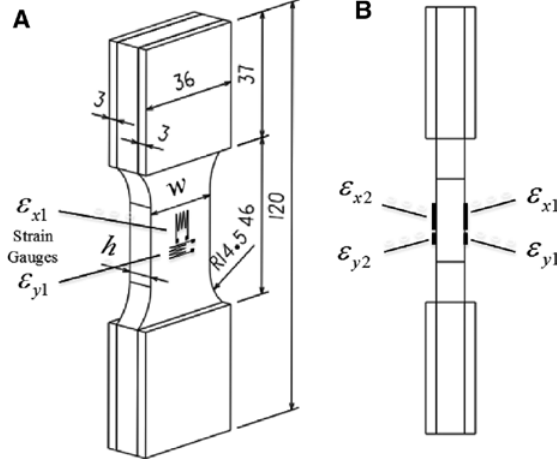
Figure 14: Geometry and strain gauges of specimen.